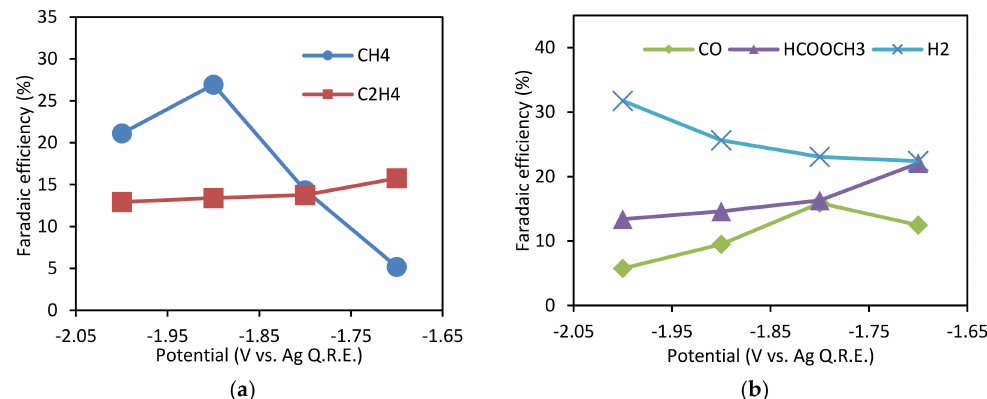
Figure 4. Influence of potential on the Faradaic efficiencies of products during the electrochemical reduction of CO 2 at Cu/carbon black electrode in NaCl/methanol. ( a ) hydrocarbons; ( b ) CO, HCOOCH 3 , and H 2